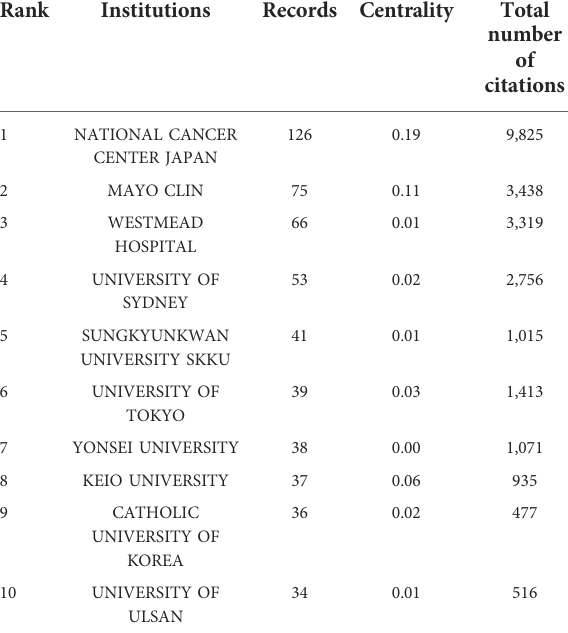
TABLE 2 Top 10 institutions in terms of publications. TABLE 3 Top 10 institutions in terms of